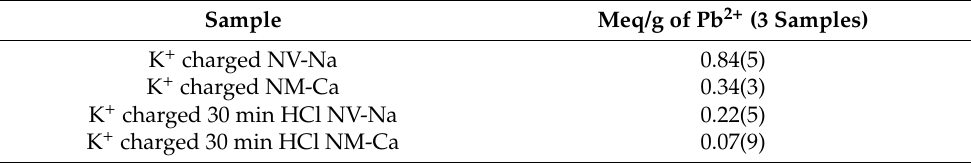
Table 6. The Pb 2+ removal by the K + charged zeolites at a time of 5 days at 35 ◦ C.